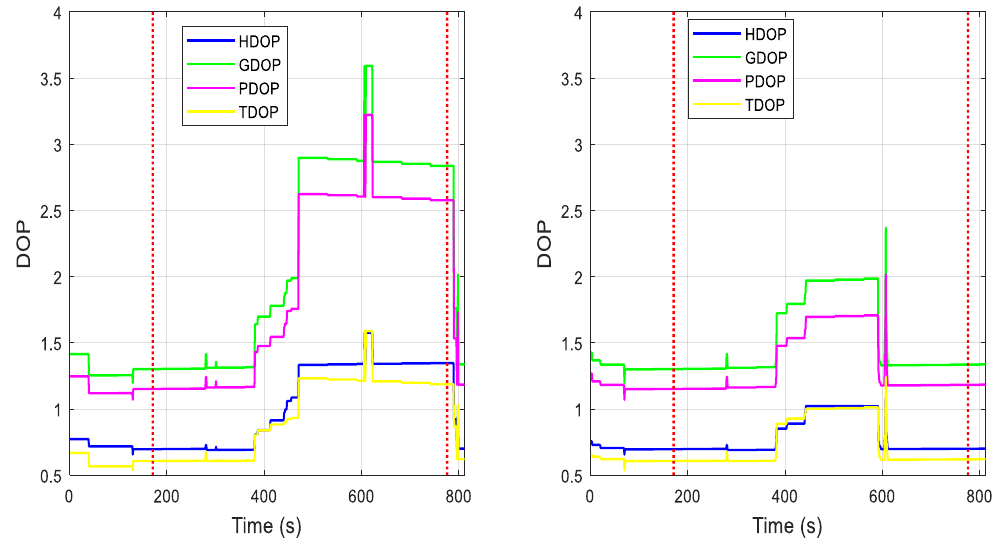
Figure 11. DOP values. ( Left figure )—scenario #2, ( right figure )—scenario #3.